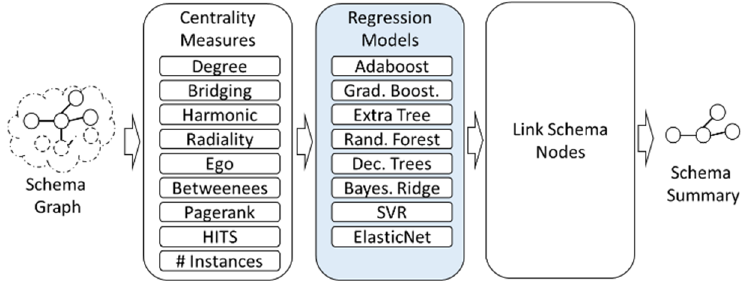
Figure 2. SumMER’S procedure for constructing schema summaries.